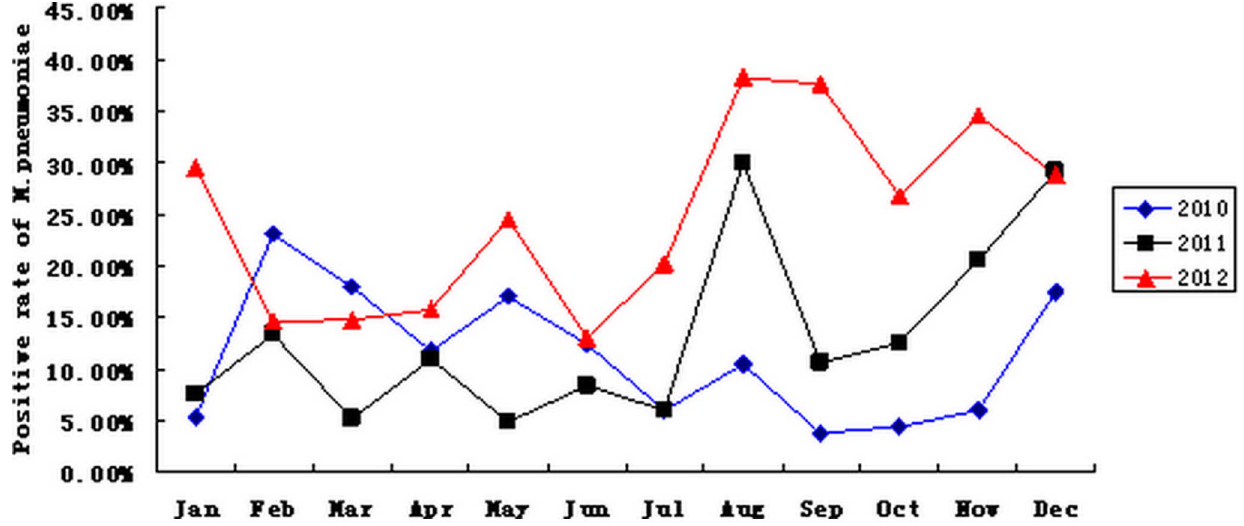
Figure 1. Positive rate of M.pneumoniae detection from January 2010–December 2012.